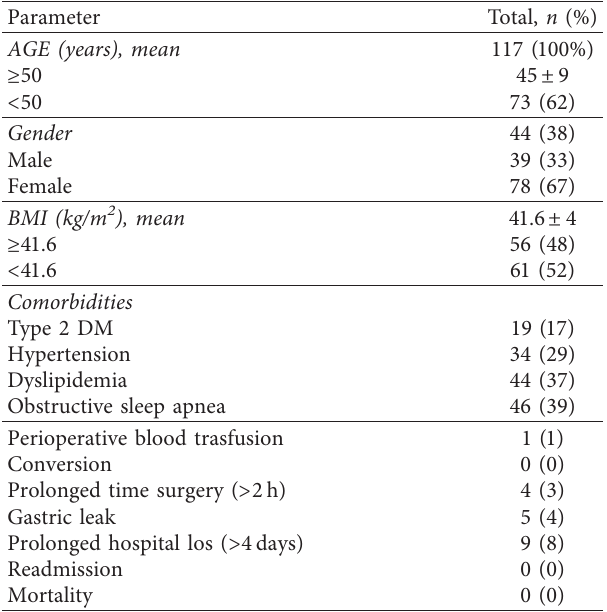
Table 2: Demographic, clinical, surgical, and pathologic details of the study